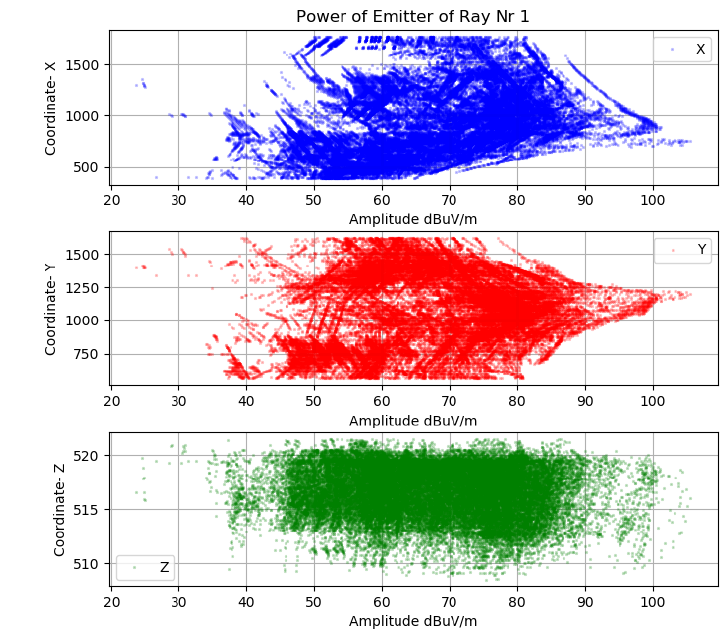
Figure 20. Ray-tracing amplitude fingerprint Sensor 1.